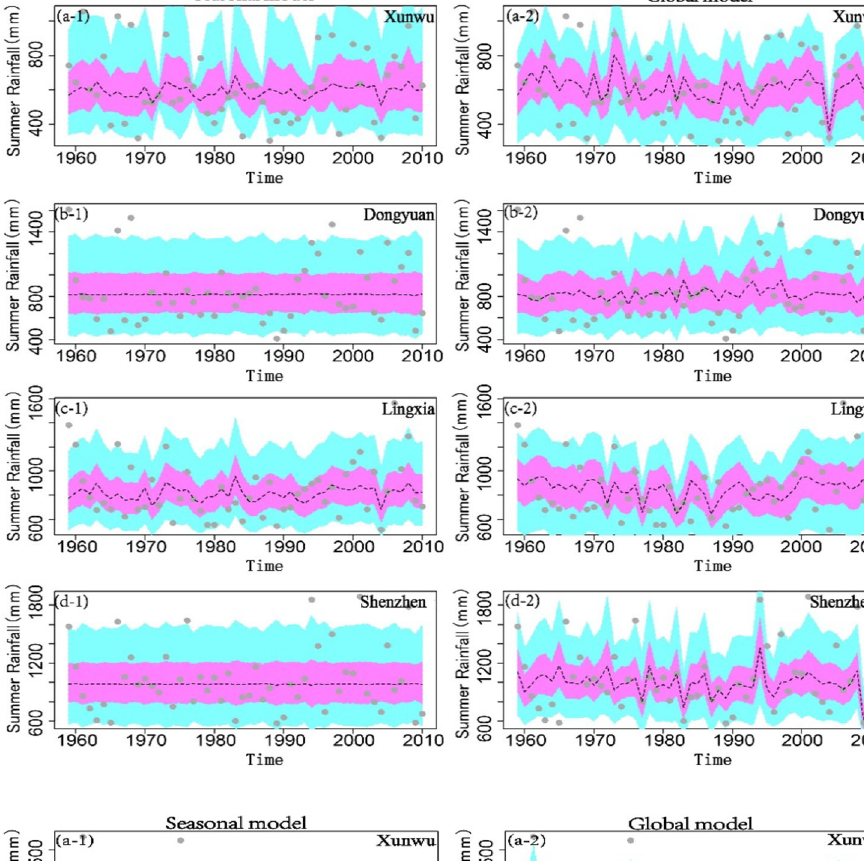
Fig. 9 Modeled autumn precipitation by the seasonal model (left) and the global model (right) at four selected stations (Xunwu, Dongyuan, Lingxia, and Shenzhen) in the East River basin in southeastern China. The black dashed line denotes the 50% percentile, the pink region shows the interval defined by the 25 and 75% percentiles, and the greenish- blue region indicates the interval defined by the 5 and 95% percentiles. The grey points denote the observed precipitation